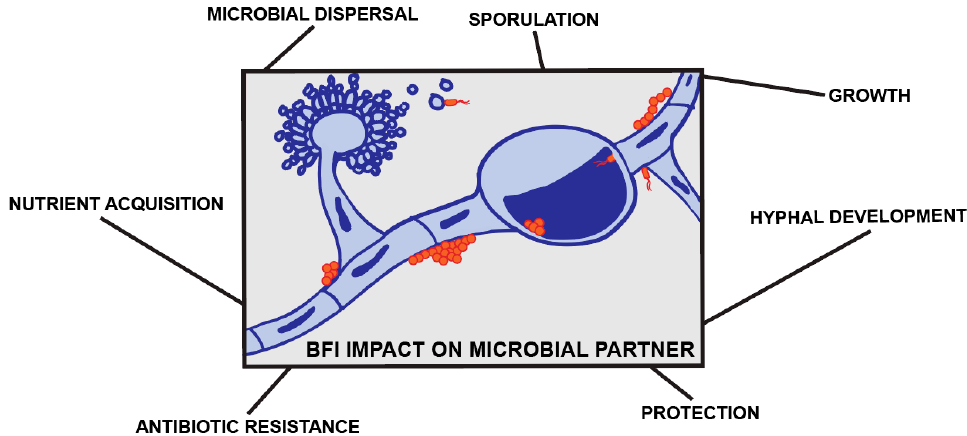
Figure 1. Bacterial-fungal interactions (BFI) impact on microbial partners. Bacterial (orange) and fungal (blue) interactions have impacts on each other’s growth and development in addition to competitive advantages associated with protection, dispersal, and nutrient acquisition.